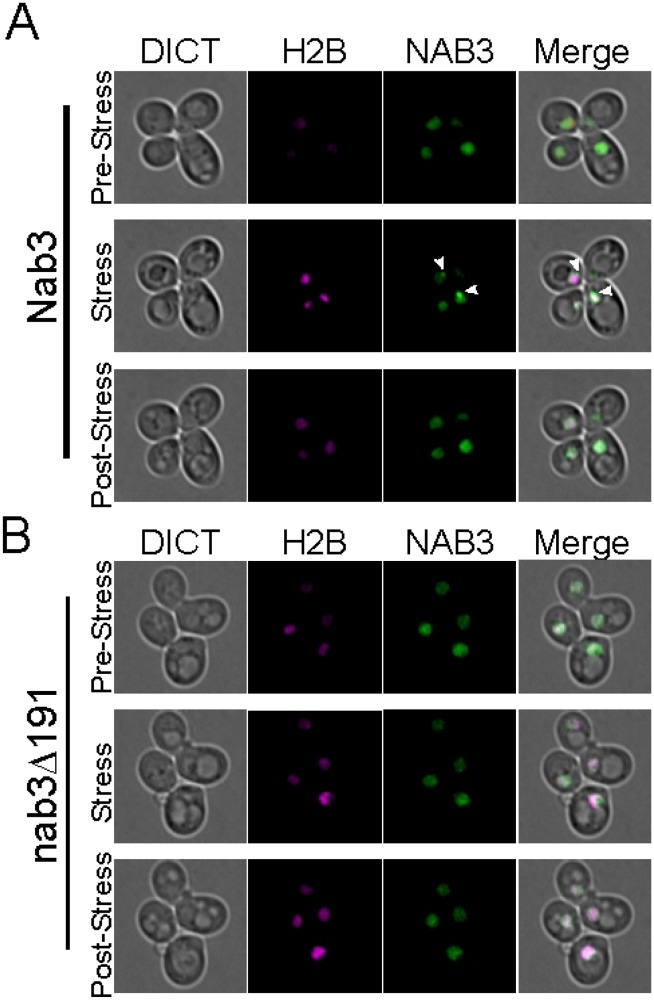
Dynamic recruitment and dissociation of the Nab3 granule.Strains (A) DY32309 (GFP-Nab3) and (B) DY3233 (GFP-nab3Δ191) were examined in a microfluidics chamber using bright field (“DICT”), time-lapse microscopy prior to, during, and after glucose starvation. The nucleus was marked with mCherry-tagged histone H2B(H2B), Nab3 and nab3Δ191 were GFP-tagged(NAB3). Images are single frames of maximum intensity projections from Z-stacks. Cells in glucose-containing medium show a pan-nuclear distribution of Nab3 (“pre-stress” row of A and B). After 2 hr of glucose depletion the Nab3 signal condenses (white arrowheads) in wild type but not in nab3Δ191 (“stress” row of A and B). Ten min following refeeding with glucose-containing medium, the Nab3 granule expands back into a pan-nuclear signal (“post-stress” row) A and B. Time lapse video is available as Supporting Information for both GFP-Nab3 and GFP-Nab3Δ191 expressing strains.